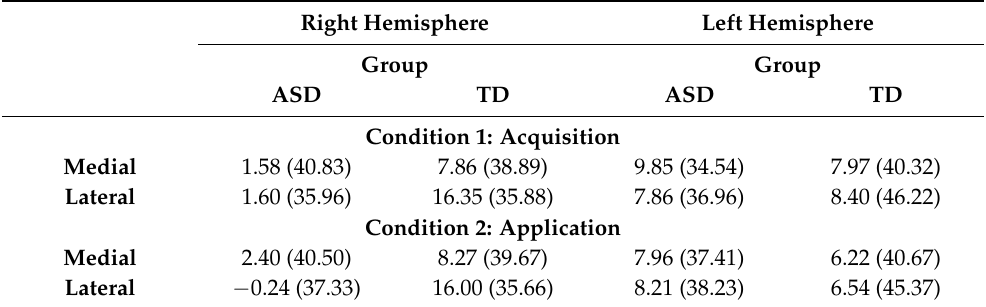
Table 3. fNIRS prefrontal activation during WCST in ASD and TD individuals (Beta